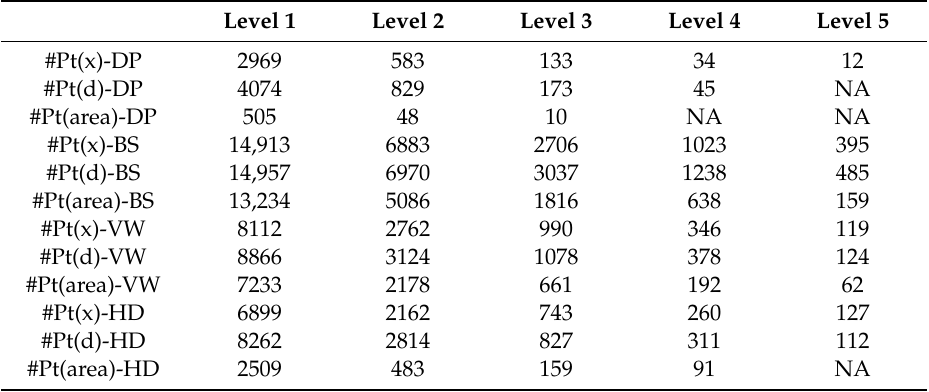
Figure 7. (Color online) The simplified results of the British coastline at different levels of details through four algorithms in terms of the polygonal shape based on x ( a ), d ( b ), and area ( c ); and the corresponding number of points ( d ) respectively. Table 3. Point numbers at the top 5 levels according to parameters x, d, and area through DP, BS, VW, and HD algorithms, respectively (Note: # = number, NA = not